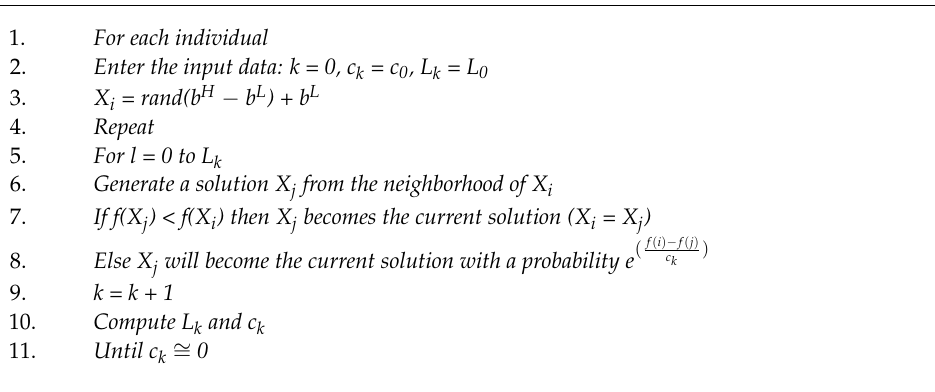
Algorithm 1. Pseudo-code of SA (PC SA